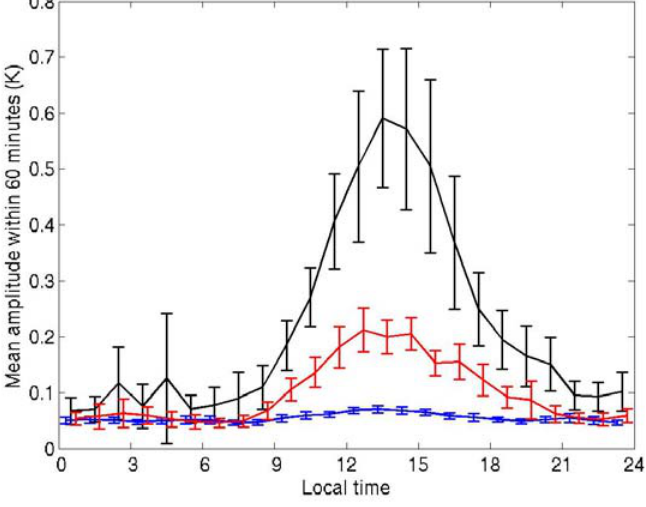
Figure 4. Average hourly temperature ranges at 0.2 m depth on the mark side, from 3 February 2005 to 20 February 2006. Any linear trend within each hour was removed. Vertical lines indicate 95% confidence intervals. Blue line: days with diurnal temperature amplitude <1.0 K; red line: amplitude ≥ 1.0 K and <2.0 K; black: amplitude ≥ 2.0